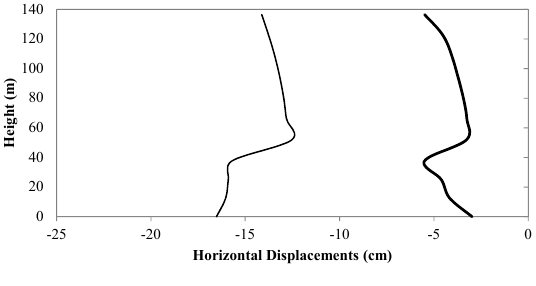
c) The maximum horizontal displacements in downstream direction according to non-linear analysis.